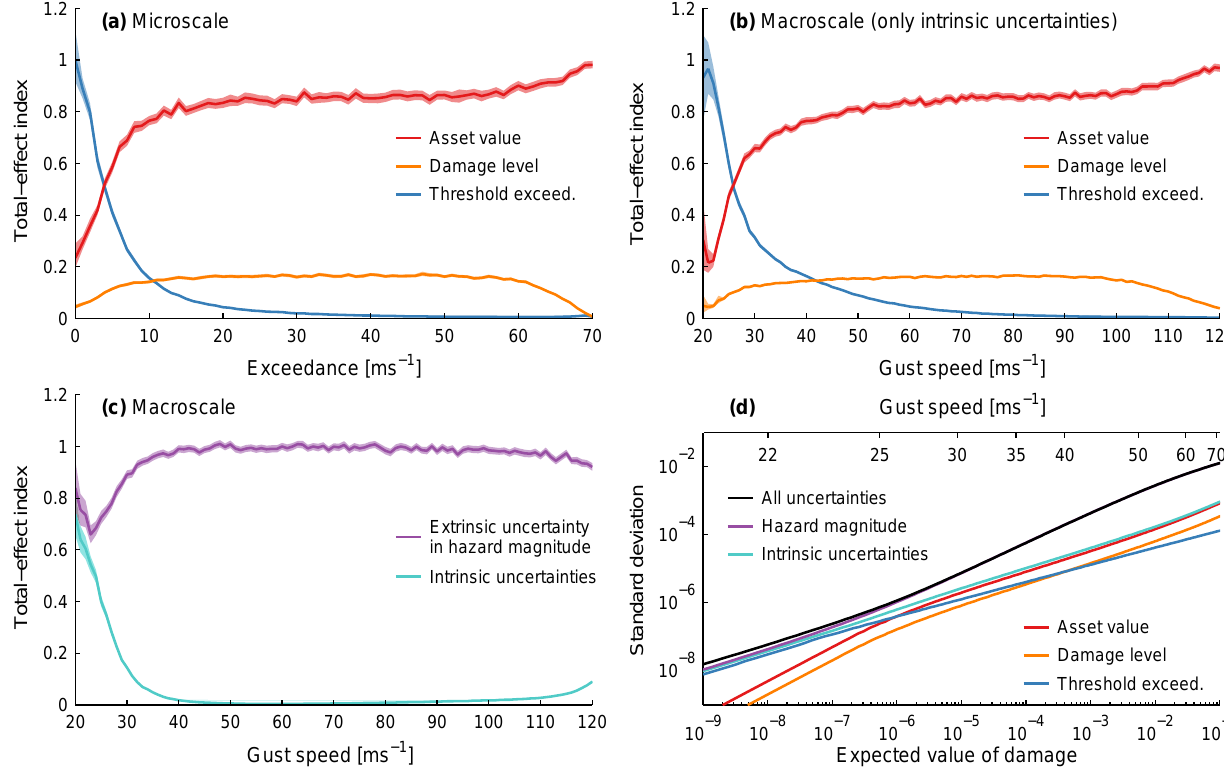
Figure 7. (a–c) show the results of variance-based sensitivity analysis (total-effect index) for the German storm-damage case study at dif- ferent scales. Shaded areas indicate boot-strapped confidence bands. For microscale damages, (a) shows the attributable effect of intrinsic uncertainty in asset value, damage, and threshold exceedance on the total variance. Similarly, (b) shows the effect of the intrinsic uncer- tainties on the variance of the aggregated portfolio. In (c) , the portfolio-aggregated microscale uncertainties are weighed against the hazard uncertainty, i.e. error in estimated flood level. (d) shows the increasing standard deviation against the expected value of damage estimates on a log–log scale. Each curve includes the uncertainty sources indicated by the